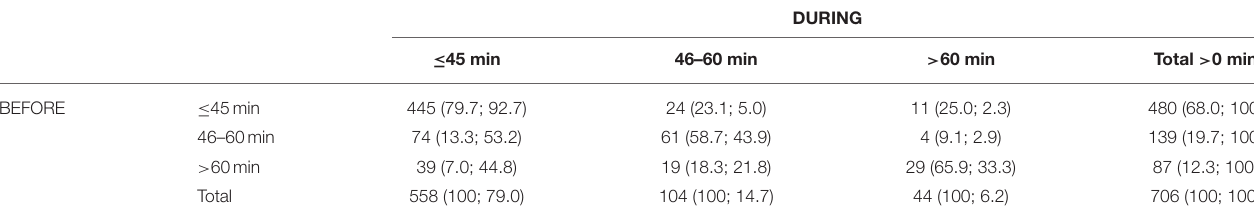
TABLE 4 | Contingency table for comparison of frequency (category percentages for during; category percentages for before) of duration of an individual session of extracurricular sport activities before and during lockdown.